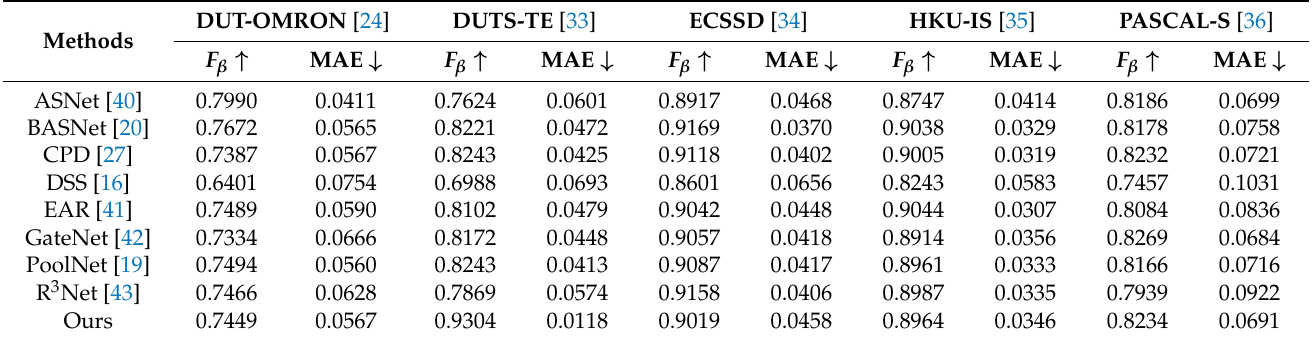
Table 1. Quantitative comparisons are made with 8 state-of-the-art methods on 5 benchmark datasets.